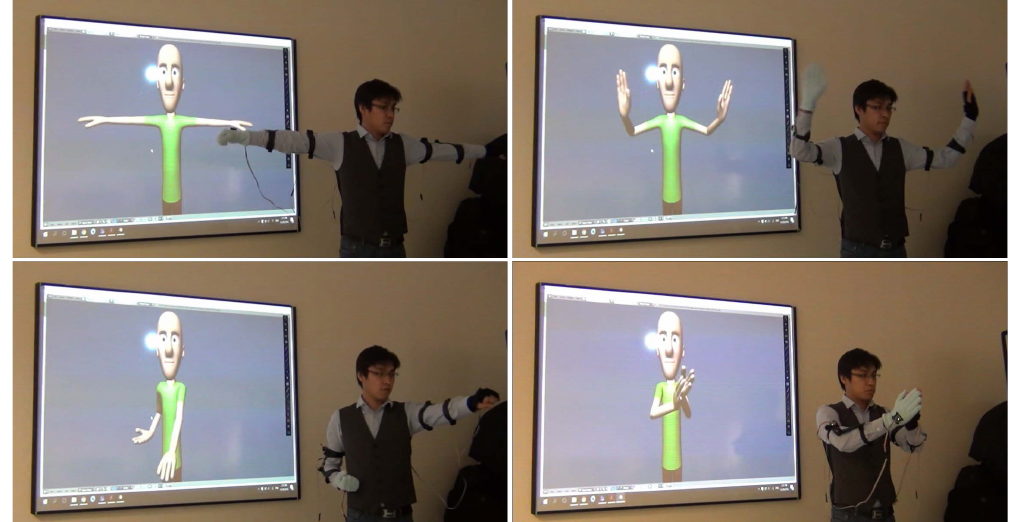
Figure 9. Human operator’s double-arm motion visualization experiment using the Phase 2 arm motion-tracking system at four different time